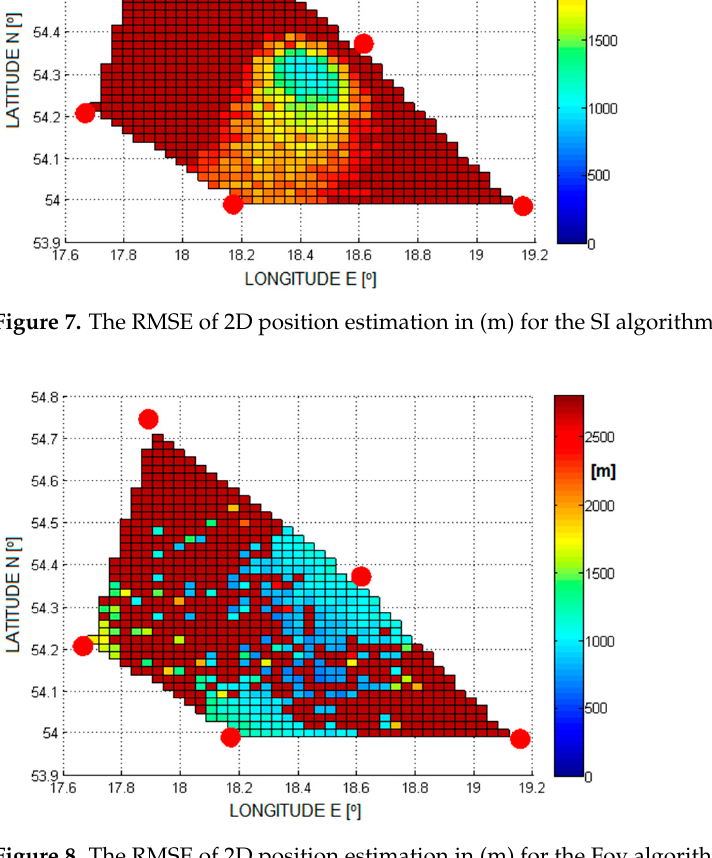
Figure 8. The RMSE of 2D position estimation in (m) for the Foy algorithm (TDoA error is ± 5 µ s). For the accepted TDoA errors, the best results were obtained for the Foy algorithm.